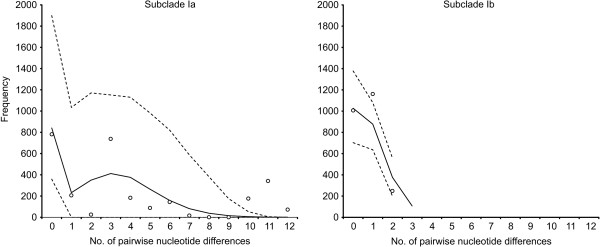
COI mismatch distributions of Oncomelania h. robertsoni. COI-based mismatch distributions of specimens from the Deyang-Mianyang area belonging to subclades Ia and Ib (see Figure 2). The distributions of pairwise nucleotide differences (circles) were tested against the spatial expansion model (black line). The 95% confidence intervals of the coalescent simulations are indicated by dashed lines.